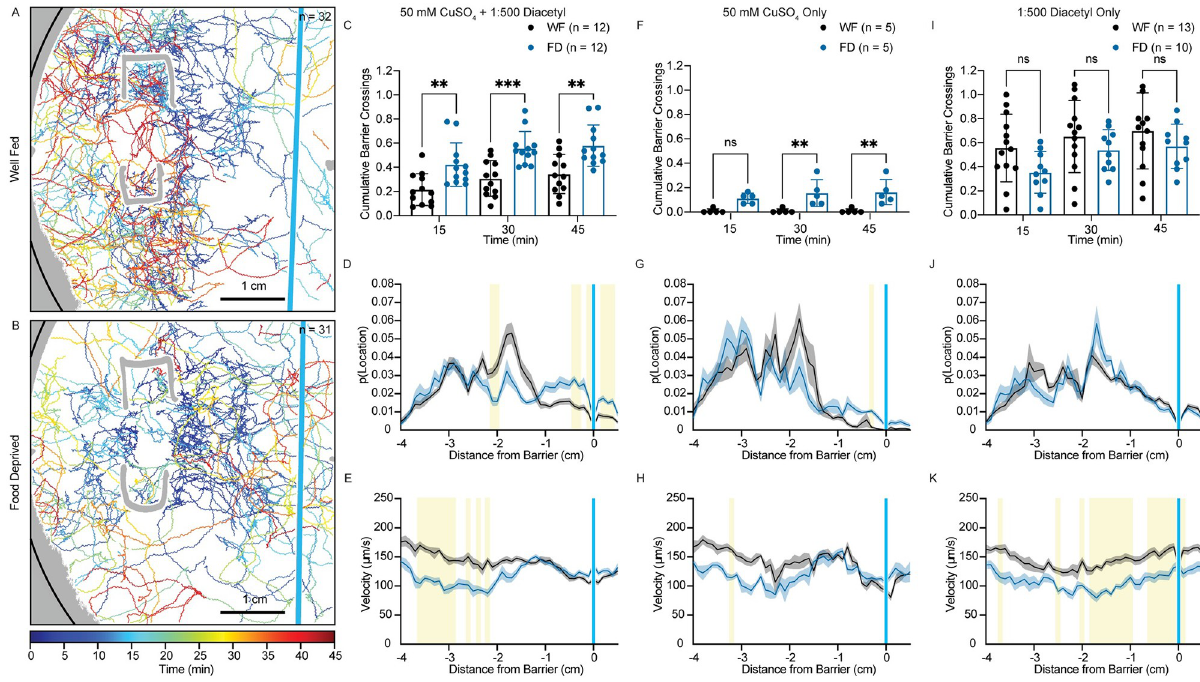
Fig 2. Riskier search strategies in food-deprived animals. (A) Worm tracks (n = 32) are plotted for a representative sensory integration assay of well- fed animals behaving in the presence of 50mM CuSO 4 (blue stripe) and 1 μ l 0.2% diacetyl (1:500) (location out of view to the right). Regions of the plate that were not able to be tracked are in gray with the edge of the plate indicated in black. Tracks are plotted and color coded for time (0 to 45 minutes). (B) Worm tracks (n = 31) are plotted for a representative sensory integration assay of 3 hour food-deprived animals. Conditions and plotting the same as in A. (C, F, I) The fraction of mean cumulative net barrier crossings is plotted at three time points (15, 30, and 45 minutes). Well-fed (WF) animals appear with black dots and food-deprived (FD) animals are indicated with blue dots. Each dot represents a single plate of animals. C) 50 mM CuSO 4 and 0.2% diacetyl F) 50 mM CuSO 4 , no diacetyl I) No copper, 0.2% (1:500) diacetyl. Graphs are analyzed using a two-way ANOVA to determine significant differences across well-fed and food-deprived conditions. WF/FD comparisons were then performed as pairwise comparisons within each time period as t-tests with Bonferroni corrections for multiple comparisons. � p < 0.5, �� p < 0.01, ��� p < 0.001, ���� p < 0.0001, ns p > 0.05. (D, G, J) The probability of an animal being located at 1 mm binned distances from the barrier is plotted for well-fed (black) and food-deprived animals (blue). The dark line represents the mean probability of residence with the shaded areas representing the standard error of the mean. D) 50 mM CuSO 4 and 0.2% diacetyl G) 50 mM CuSO 4 , no diacetyl J) No copper, 0.2% diacetyl. For each graph, multiple unpaired t-tests with Welch’s correction were performed with correction for multiple comparisons with Holm-Sˇı´da´k post-hoc test. Corrected p values < 0.05 are indicated by yellow shading. A comprehensive list of the statistics can be found in S2 Table. (E, H, K) The mean velocity of animals as a function of distance from the barrier is plotted for well-fed (black) and food-deprived animals (blue). Conditions, plotting, and statistics are the same as in D, G, and J.